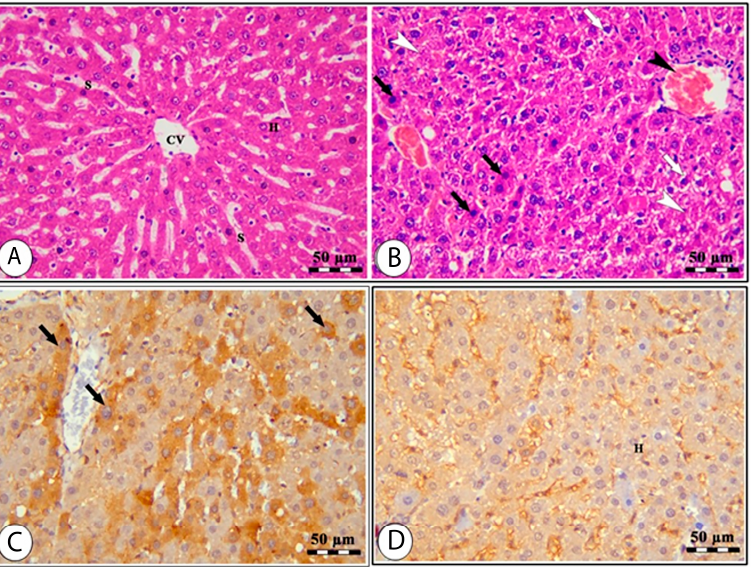
Figure 3. Liver sections of normal sea level ( A , C ) and high altitude ( B , D ) groups stained by H&E ( A , B ) and Nrf-2 IHC ( C , D ). The H&E-stained liver sample from the normal sea level group ( A ) shows normal hepatocytes (H), hepatic sinusoids (S), and the central vein (CV). The H&E-stained liver sample from the high-altitude group ( B ) shows a congested central vein (black arrowhead), areas of necrosis (white arrowheads), vacuolar degeneration (white arrows), pyknotic nuclei, and swelling of hepatocytes (black arrows). The Nrf-2 IHC-stained liver sample from the normal sea level group ( C ) shows hepatocytes with Nrf-2 positive staining (H). The Nrf-2 IHC-stained liver sample from the high-altitude group ( D ) shows hepatocytes with less Nrf-2 staining (black arrows).